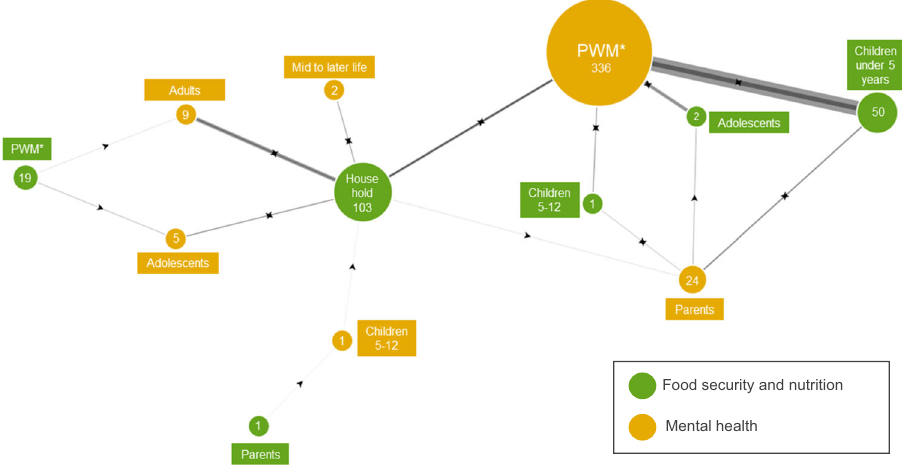
Fig. 7 | Network diagram of studies showing the frequency of investigated relationships between FSN in one population group and mental health in another group by the hypothesized direction of the relationship. The size of thebubblesandwidthofthelinksbetweenthemisscaledaccordingtothenumber